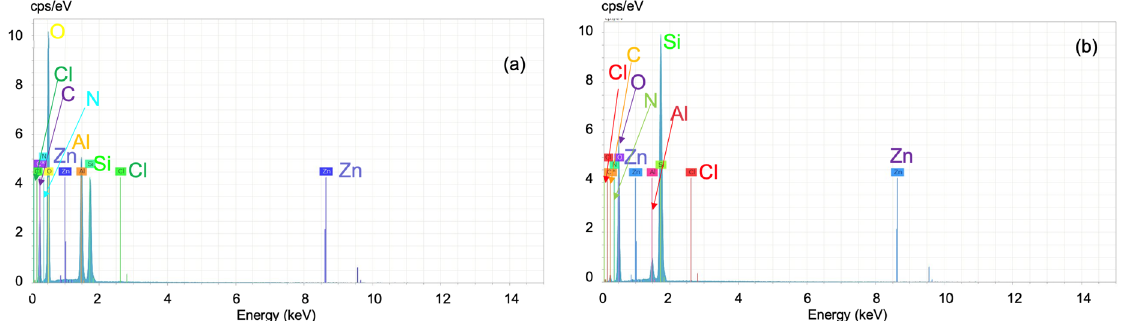
Figure 4. EDS spectra showing the presence of Zn 2+ on the surface of KAO ( a ) and HAL ( b ). Table 1. AO or AO + Zn 2+ sorption capacity on different types of clay minerals. Clay Minerals